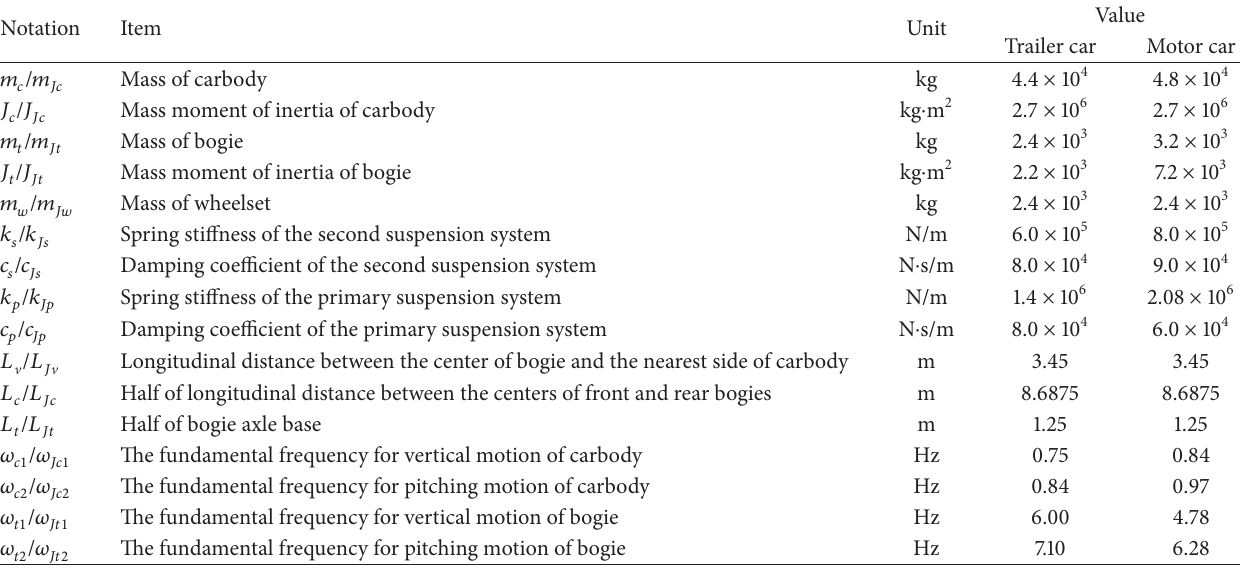
Table 1: Parameters for trailer car and motor